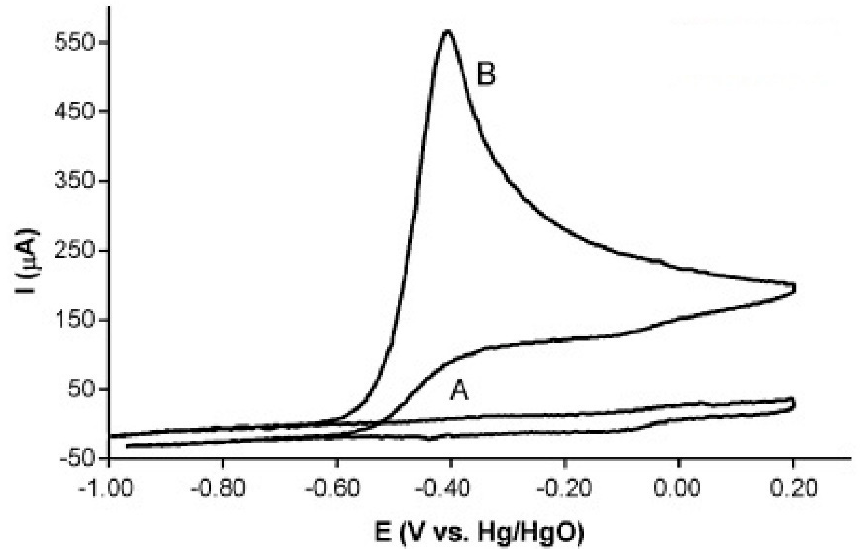
Figure 2. Cyclic voltammograms of (A) 2 M NaOH and (B) 1 mM NaBH 4 in 2 M NaOH at 6 mm Au disk at 0.100 V s − 1 . Reproduced from ref. [40] with permission from the publisher.